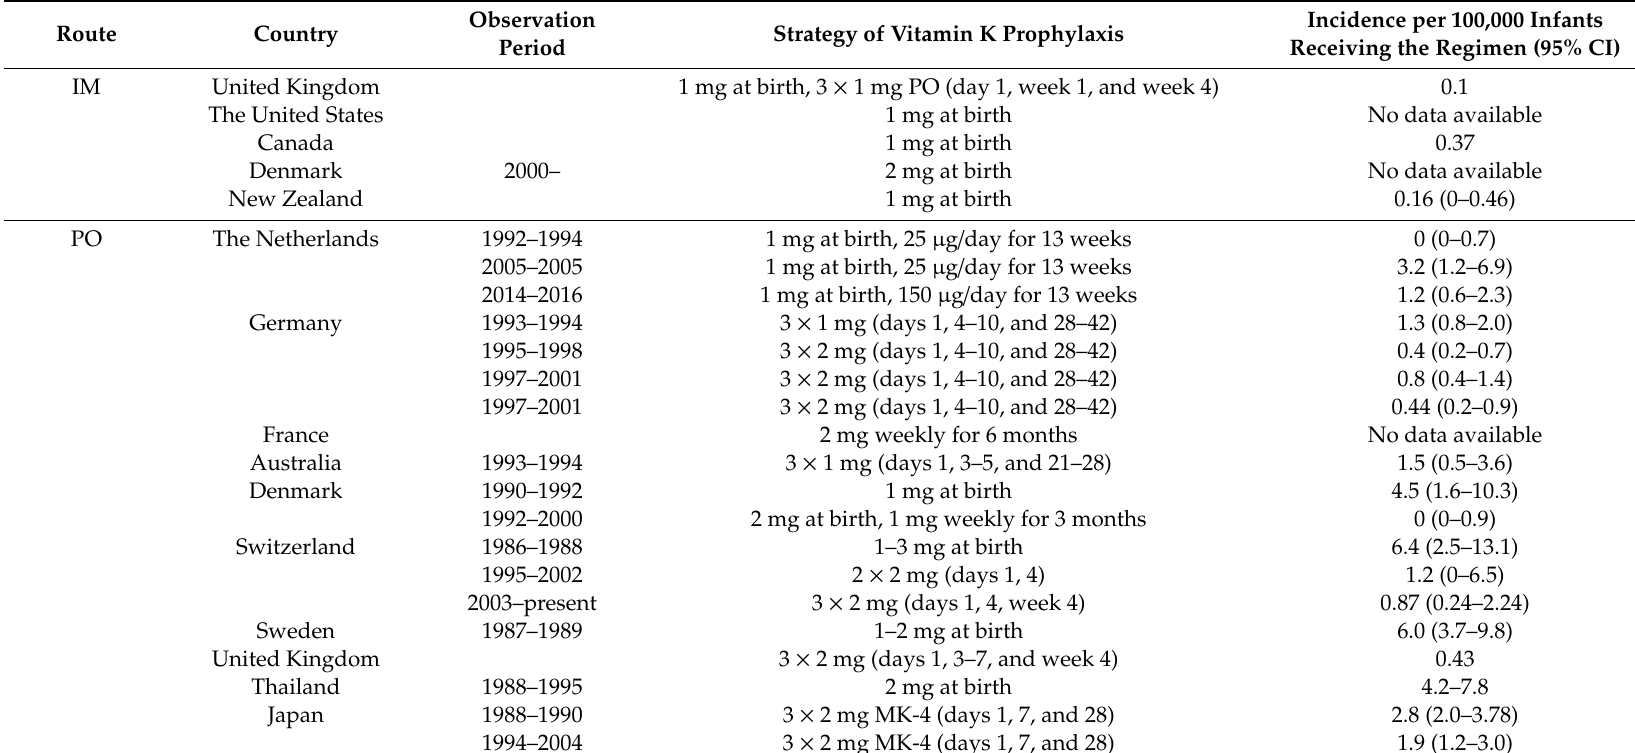
Table 6. Strategy of prophylaxis for vitamin K deficiency bleeding (VKDB) and incidence of late-onset VKDB in di ff erent